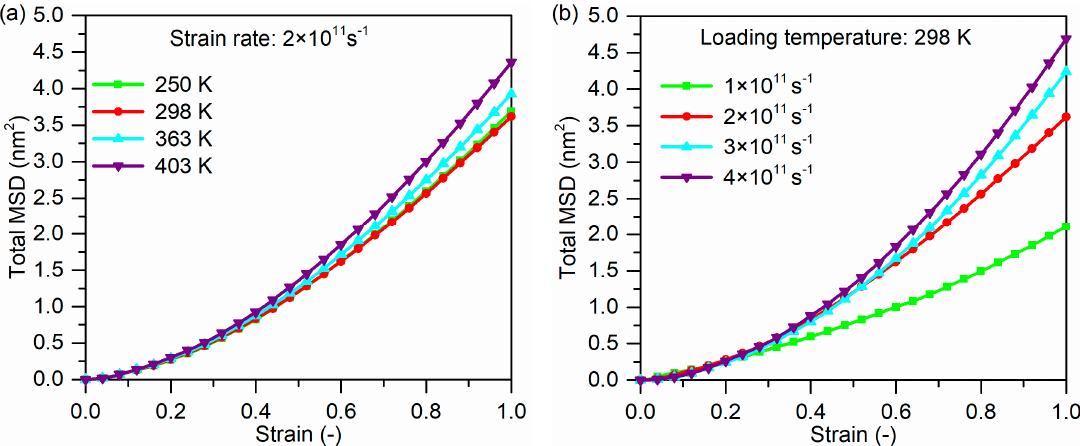
Figure 9. Mean square displacement (MSD) of PP molecules of glass fiber / PP composites models under: ( a ) different loading temperatures and ( b ) different strain rates.